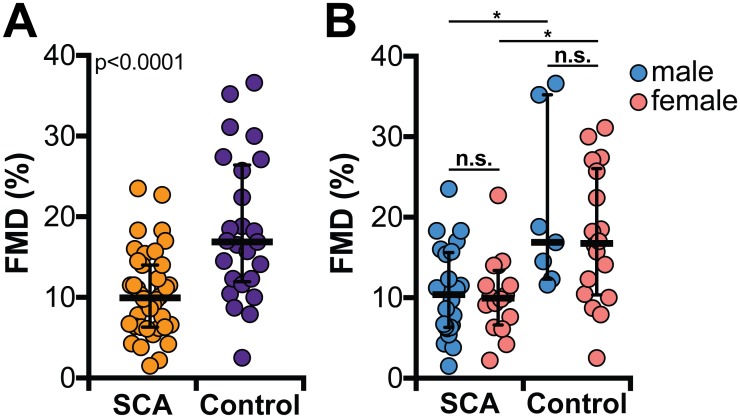
Flow-mediated vasodilation (FMD) values are reduced in sickle cell anemia patients compared to that in healthy controls independent of gender.Lines represent median and interquartile values. Data were compared using the Mann-Whitney U test (A) or Kruskal-Wallis test with Dunn’s multiple comparisons ad hoc test. *p<0.05; n.s. = non-significant.